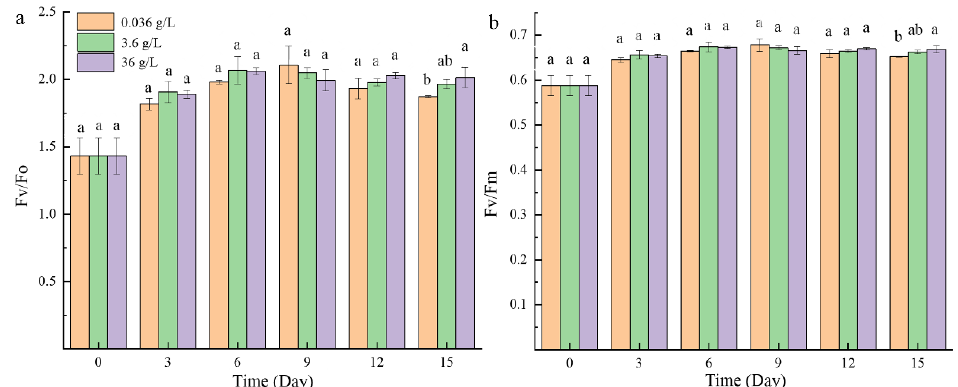
Figure 2. Effects of three concentrations of CaCl 2 on the photosynthetic activity of P. kessleri FACHB- 3316: ( a ) Fv/Fo; ( b ) Fv/Fm (The letters a, b and ab indicate the significance of the difference).